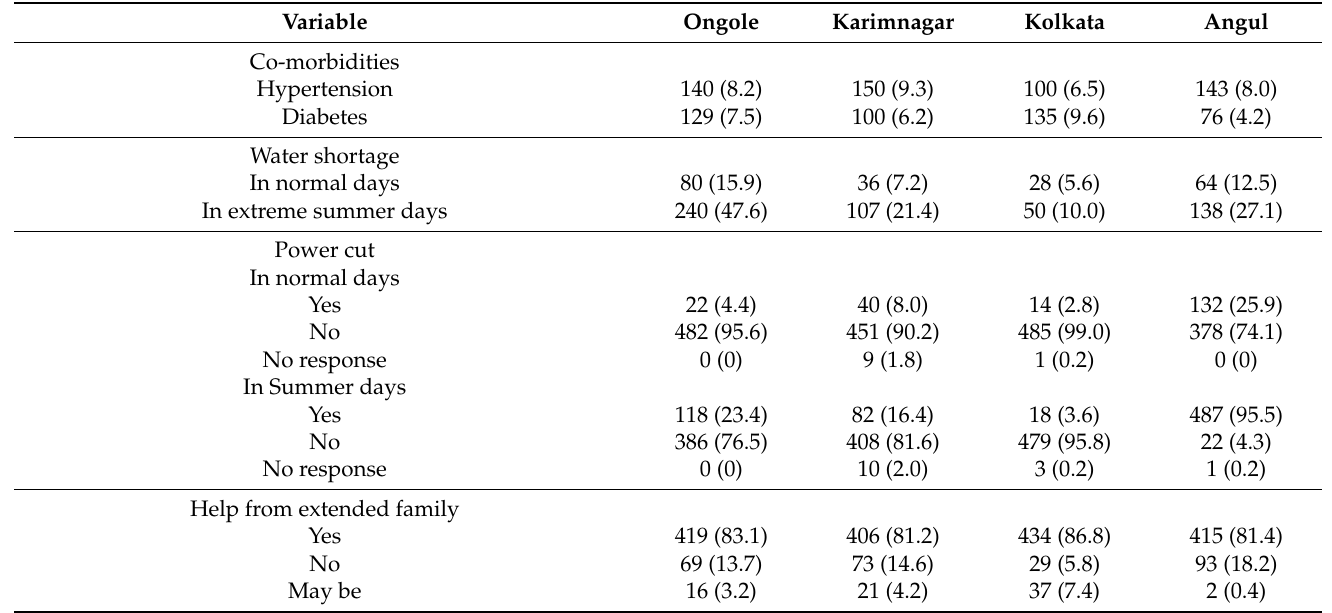
Table 4. Descriptive Statistics: Sensitivity.